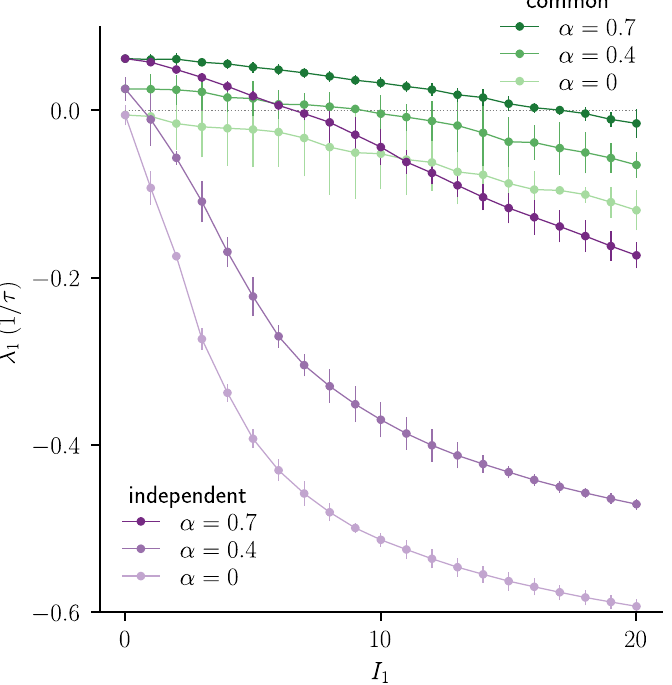
Fig 6. Difference in chaos suppression in sparsely-connected E-I network. λ 1 as a function of I 1 for common and independent inputs, showing a monotonic decrease with I 1 and a larger zero-crossing for common input. This result is qualitatively similar to that obtained in the single population network with negative mean coupling (Fig 2). Error bars indicate ± 2 std, lines are a guide for the eye. Increasing the excitatory efficacy α increases λ 1 for both common and and independent input ( α 2 {0, 0.5, 0.7}). Model parameters (parameters defined as in [16] for constant input and W I 1 W E 1 are the modulation amplitudes of the input to the excitatory and inhibitory population): N E = N I = 3500, K = 700, ffiffiffiffi p ffiffiffiffi p ffiffiffiffi p ffiffiffiffi p ffiffiffiffi p ffiffiffiffi p ¼ g a = , J ¼ (cid:0) 1 : 11 g = , J ¼ g a = , J ¼ (cid:0) g = , W ¼ g a , W ¼ 0 : 44 g , W E 1 = g α I 1 , K K K K K K g = 1.6, J EE EI IE II E I W I 1 = 0.44 gI 1 , f = 0.2/ τ